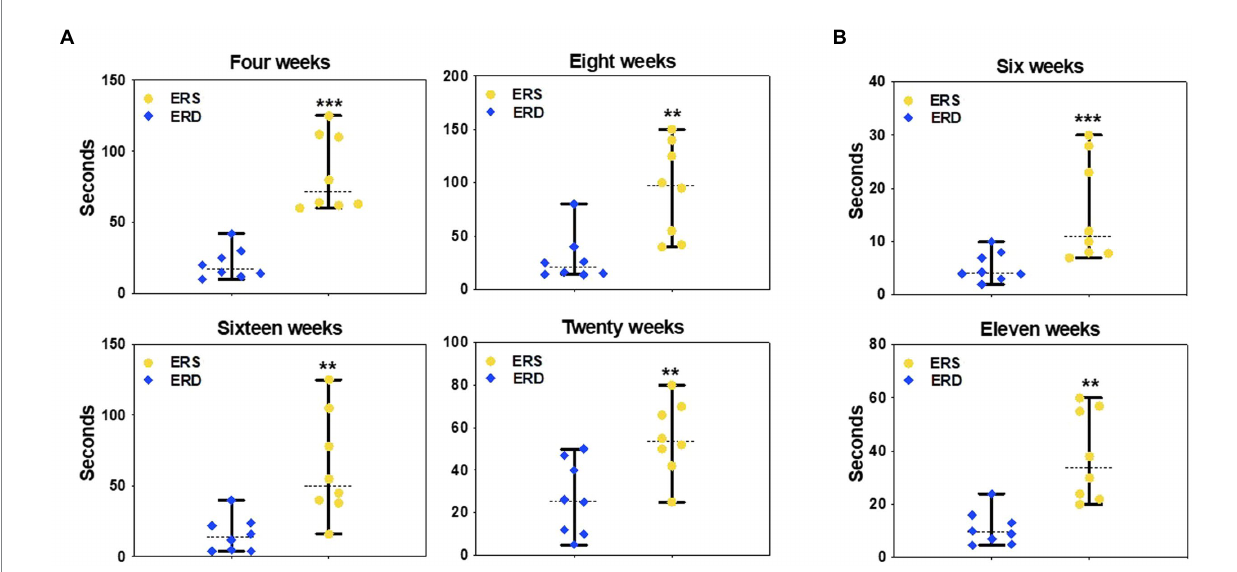
FIGURE 7 Effect of egg small EVs and RNA-sufficient (ERS) diet on spatial learning and memory in C57/BL6J mice. Latency to locate the escape platform in the Barnes maze after consuming sEV RNA rich and sEV RNA deficient diets for 4, 8, 16, and 20 weeks in C57BL/6 mice (A) . Latency to locate the escape platform in the Morris Water maze after consuming ERS or ERD diets for 6 and 11 weeks in C57BL/6 mice (B) . Data are presented as median with range ( n = 8). The middle line denotes the median. Data were analyzed by Mann–Whitney test. Bars indicate the minimum and maximum values. *Value of p <0.05; **Value of p